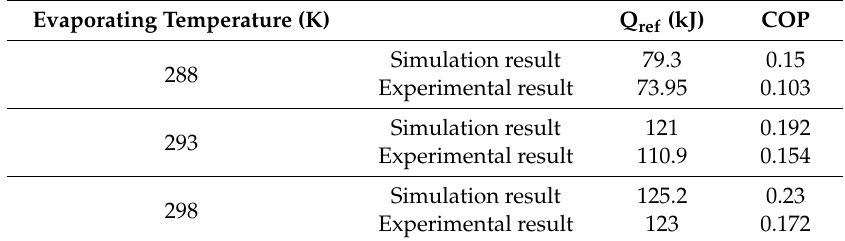
Table 2. Experimental results and simulation results at different evaporation temperatures. Evaporating Temperature (K)